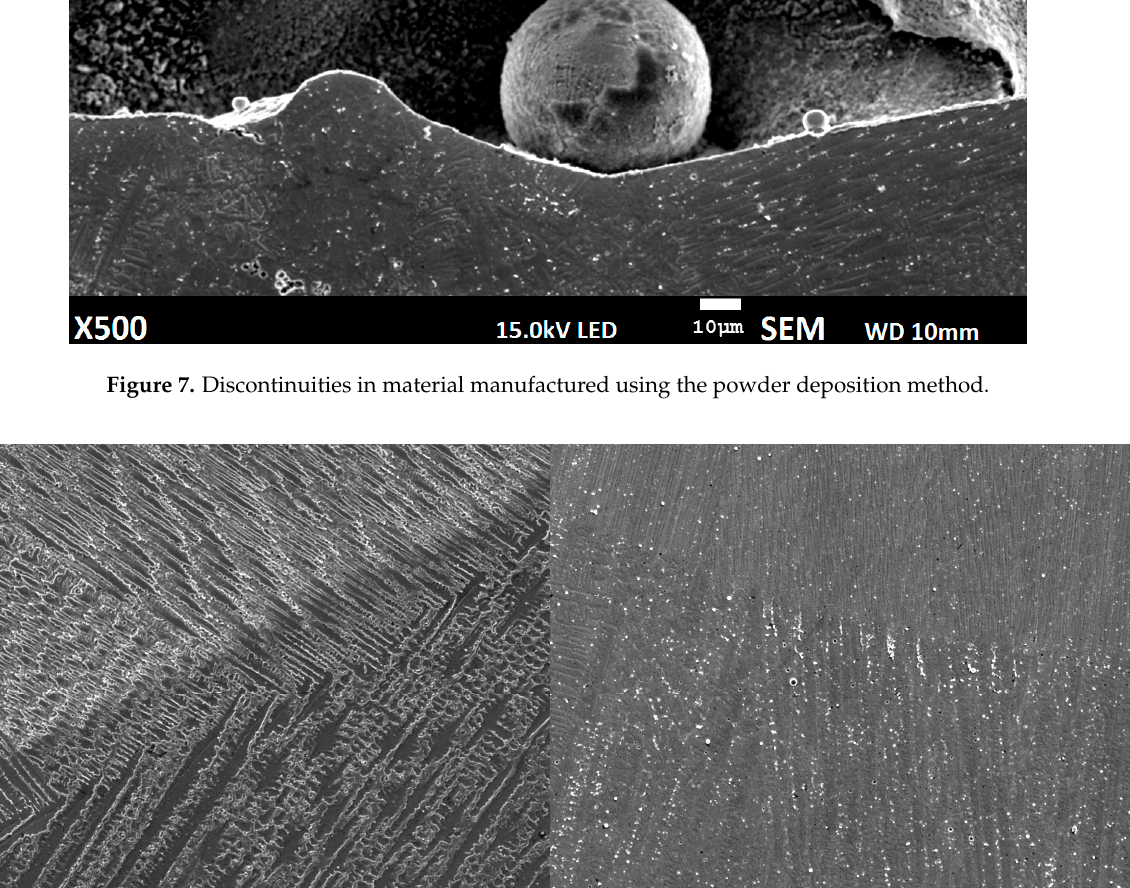
Figure 7. Discontinuities in material manufactured using the powder deposition method.